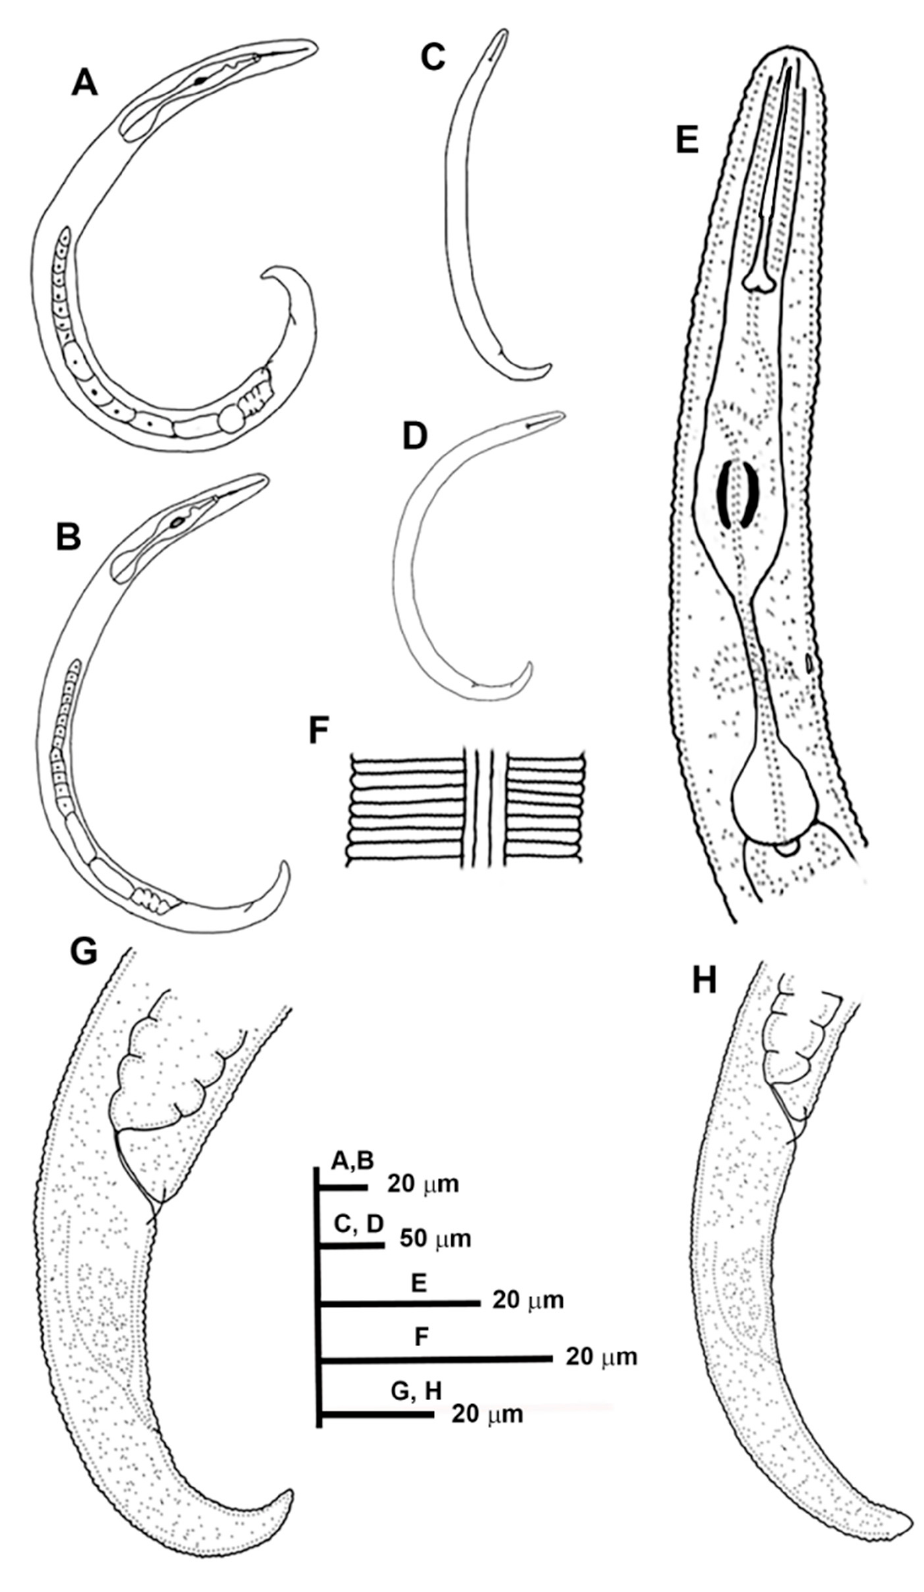
Figure 3. Line drawings of Paratylenchus indalus sp. nov. ( A – D ): Entire females; ( E ): Female pharyngeal region; ( F ): Lateral field at mid-body; ( G , H ): Female posterior region.